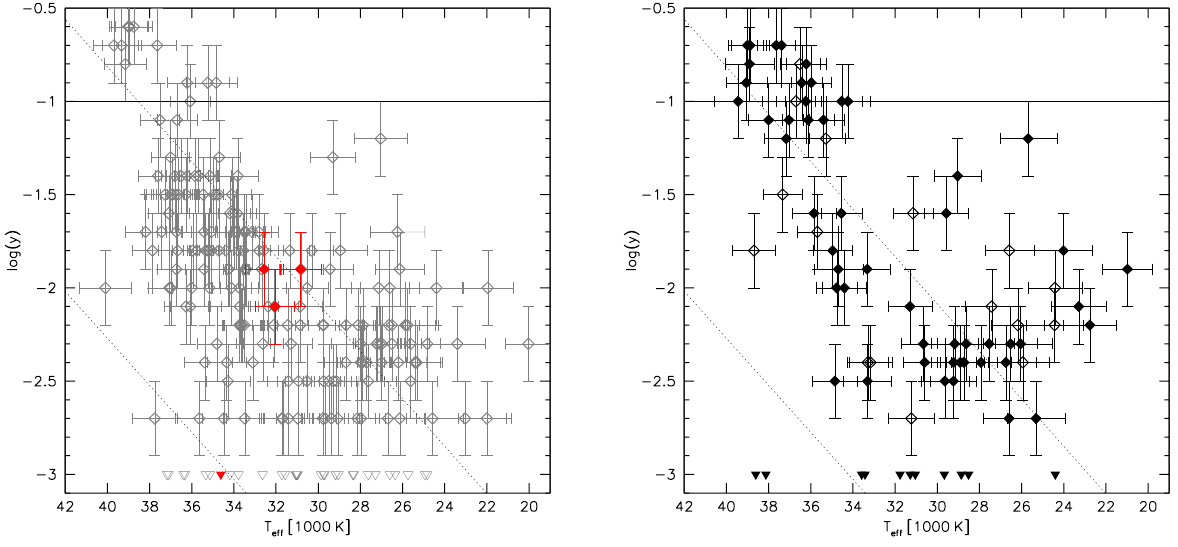
Figure 3. Helium abundance plotted against effective temperature (red filled diamonds: thin disk, grey open diamonds: thick disk, black open diamonds: halo, black filled diamonds: bona fide halo, triangles: upper limits). The horizontal lines mark the solar helium abundance. The two helium sequences discovered by Edelmann et al. (2003) are indicated as dotted lines. The left panel shows the disk sample, right panel shows the halo